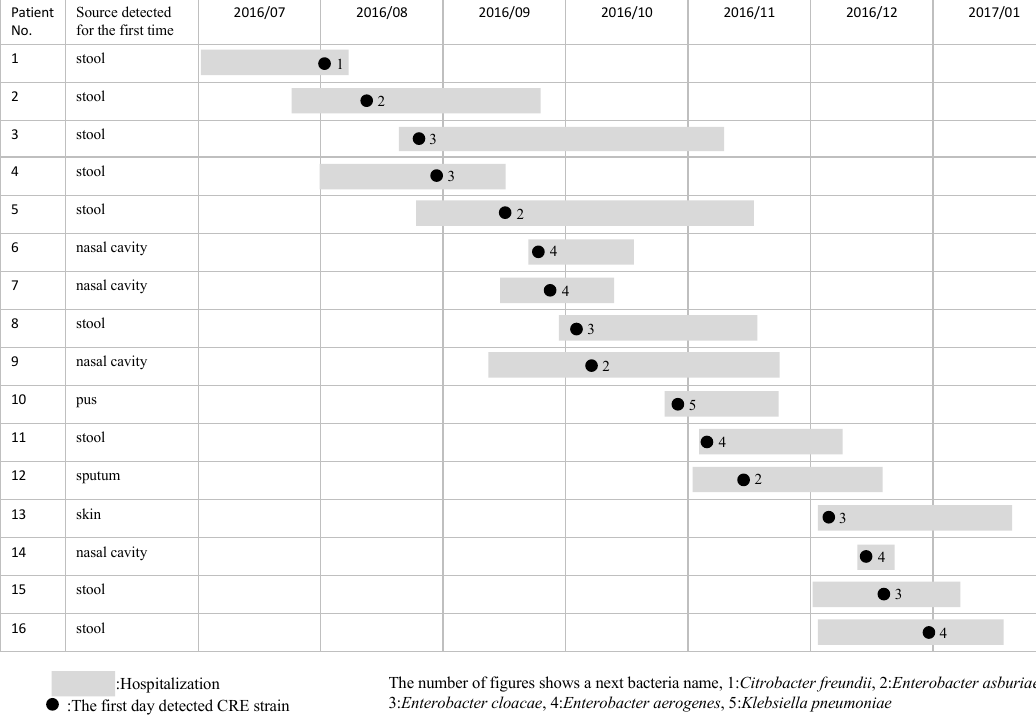
Figure 1. The time course for a CRE outbreak in the ICU. Gray shadow: period of hospitalization. Black circle: the first day of CRE strain detection. Table 1. Antibiotics susceptibolity profiles (minimum inhibitory concentrations,